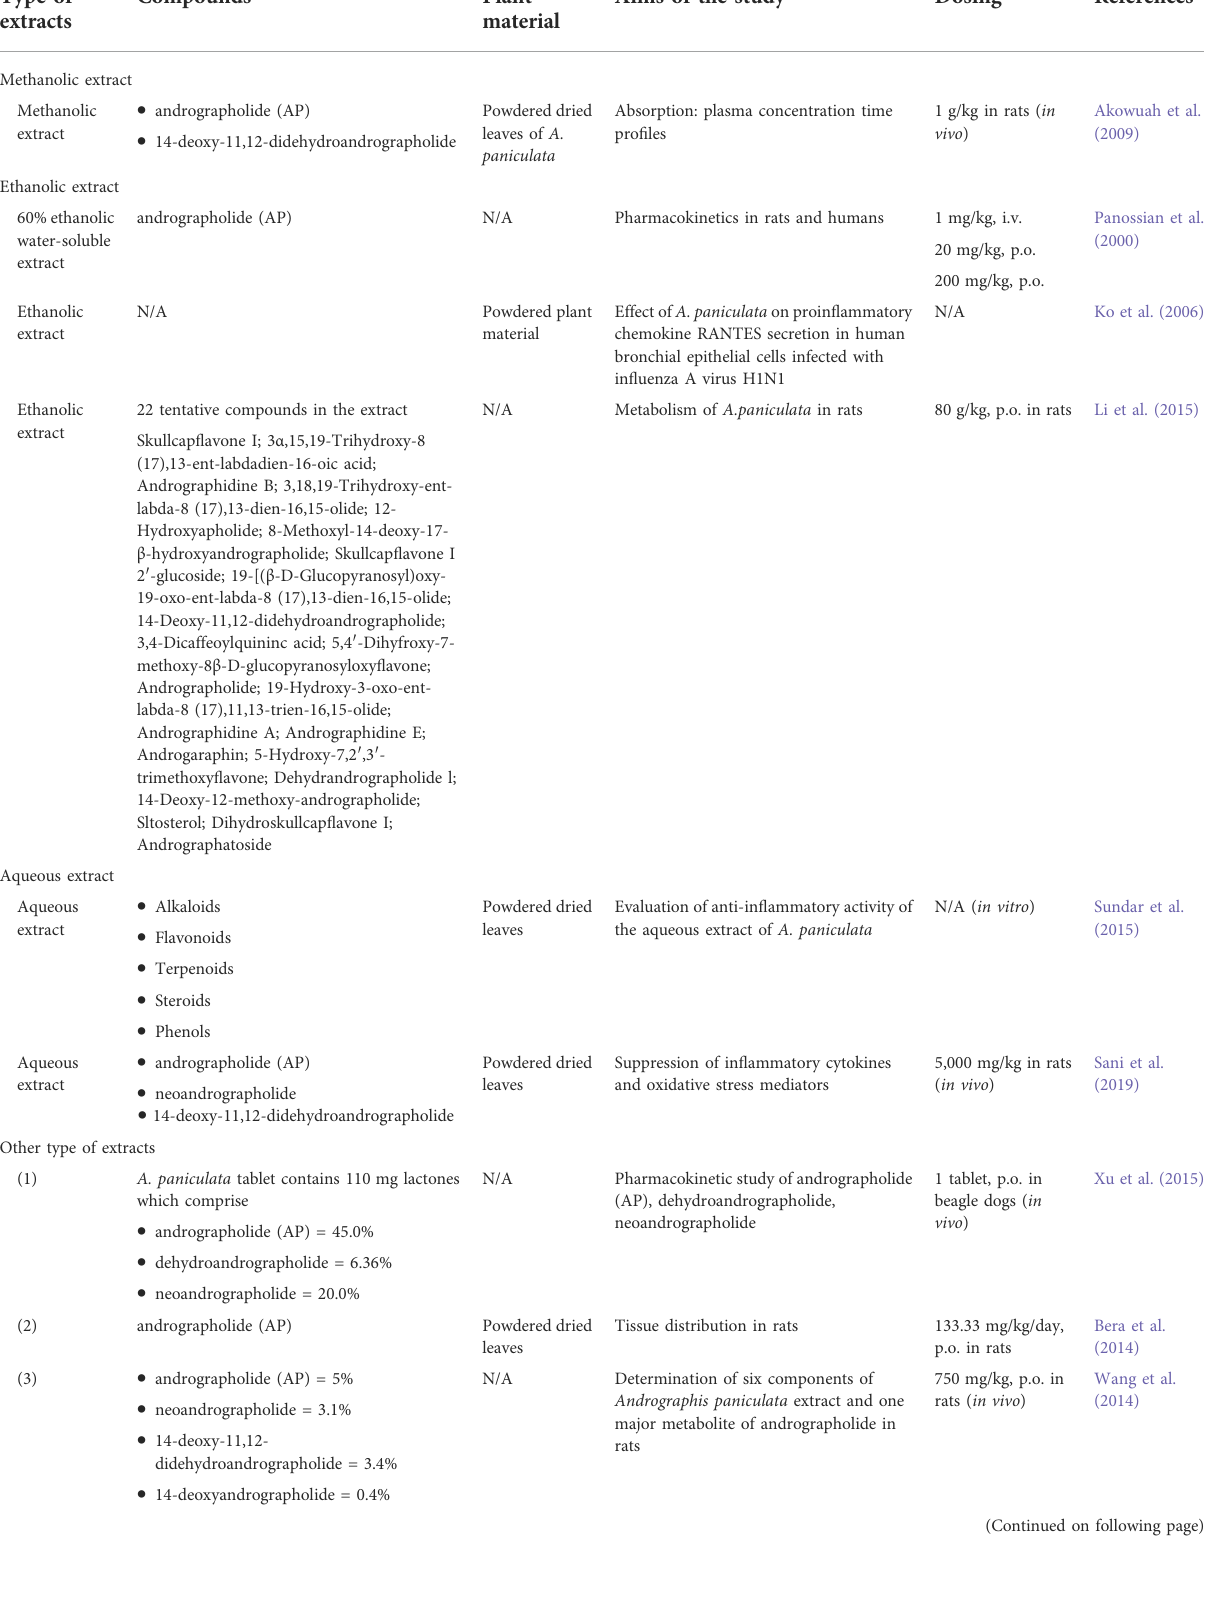
TABLE 1 Comparison of the major compounds of methanolic extract, ethanolic extract, aqueous extract, and crude powder of A. paniculata